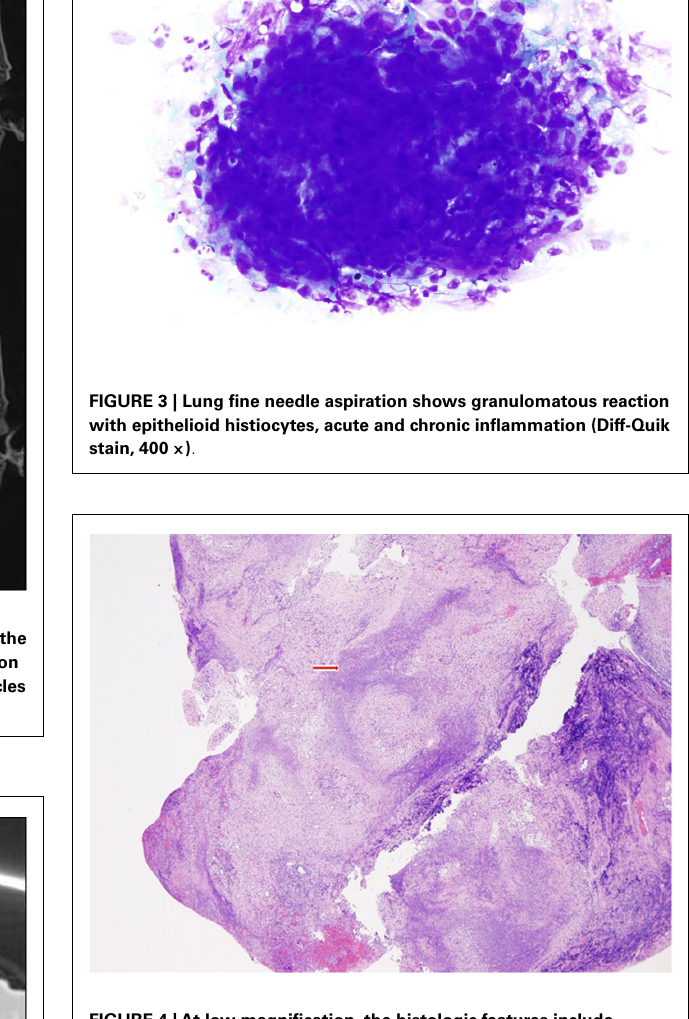
showed no evidence of sinonasal lymphoma. AFB, bacterial, and fungal cultures were